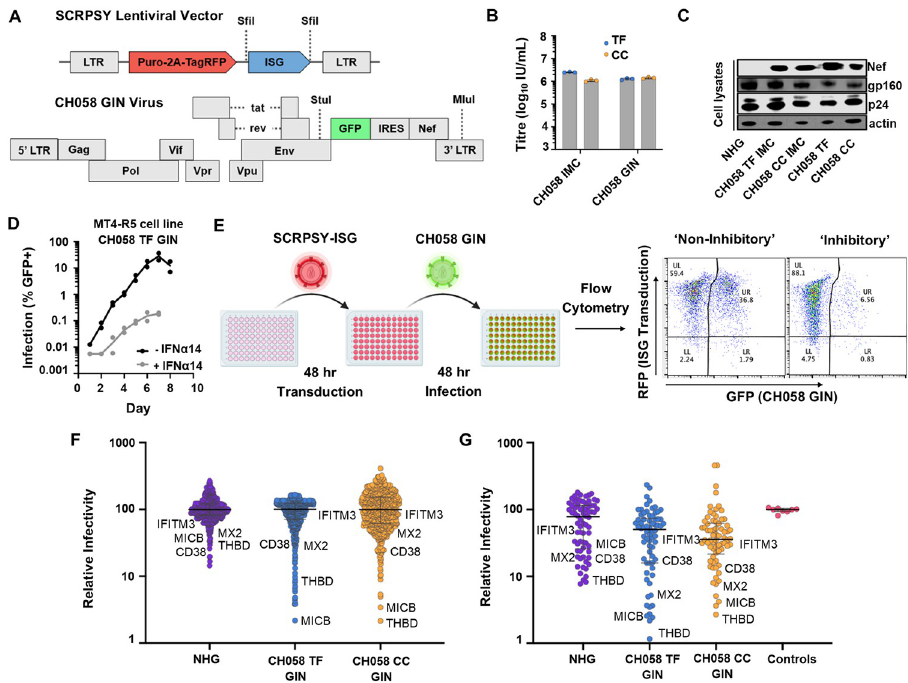
Fig 2. Arrayed ISG expression screening identifies multiple ISGs that inhibit transmitted HIV-1 and its matched CC virus. (A) A schematic of the SCRPSY lentiviral vector (GenBank accession KT368137.1) used to deliver ISGs, and of the fluorescent GFP-IRES-Nef (GIN) TF and CC viruses used. (B) The infectious titres of CH058 IMC and CH058 GIN viruses in a single cycle of infection in TMZR5 cells. Cells were treated with dextran sulphate 17–18 hours post infection and the percentage of GFP positive cells was determined at 48 hours post-infection using flow cytometry. (C) Western blot analysis of viral antigens present in TMZR5 cell lysates infected with the indicated virus for 48 hours. (D) Growth kinetics of CH058 TF GIN in clonal MT4 CCR5-R126N in the absence and presence of 0.5 pg/ μ l IFN α 14. Cells were treated with IFN α 14 24h prior to infection. (E) A schematic of the ISG screening pipeline used in panel F. (F) Normalized infection (median centred) of cells expressing different ISGs (each dot represents the observed infection in the presence of a single ISG). (G) Validation screen, conducted as in E and F, of ISGs ‘hits’ selected that were more inhibitory than human Mx2 in panel F. Empty SCRPSY transduced MT4-R5 cells were used as controls.